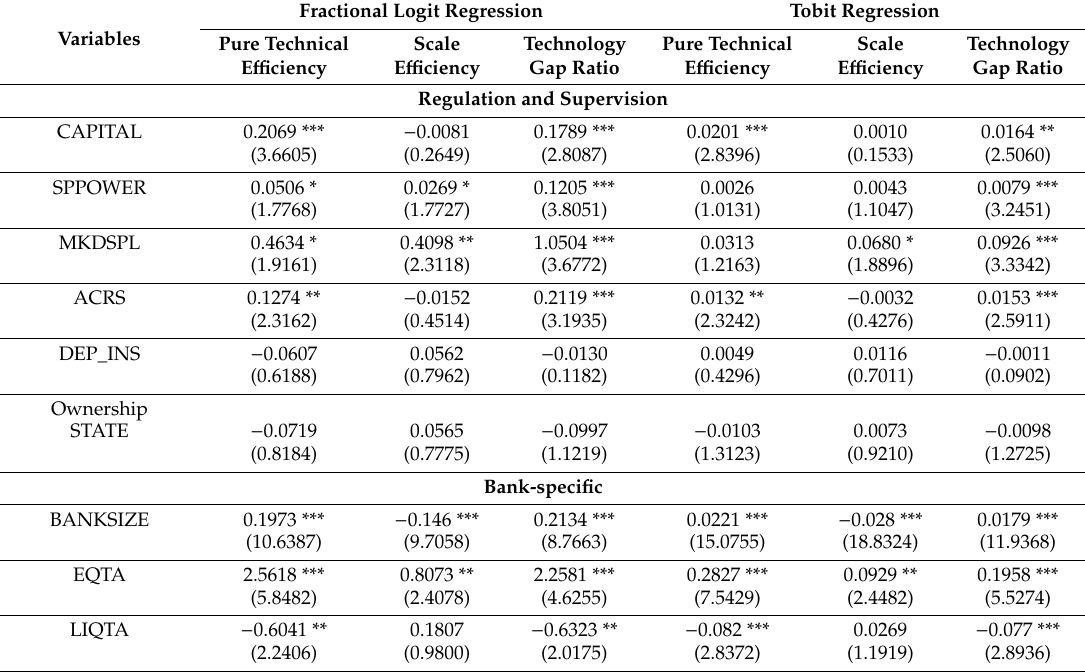
Table 10. Robustness test results: Fractional logit regression and tobit